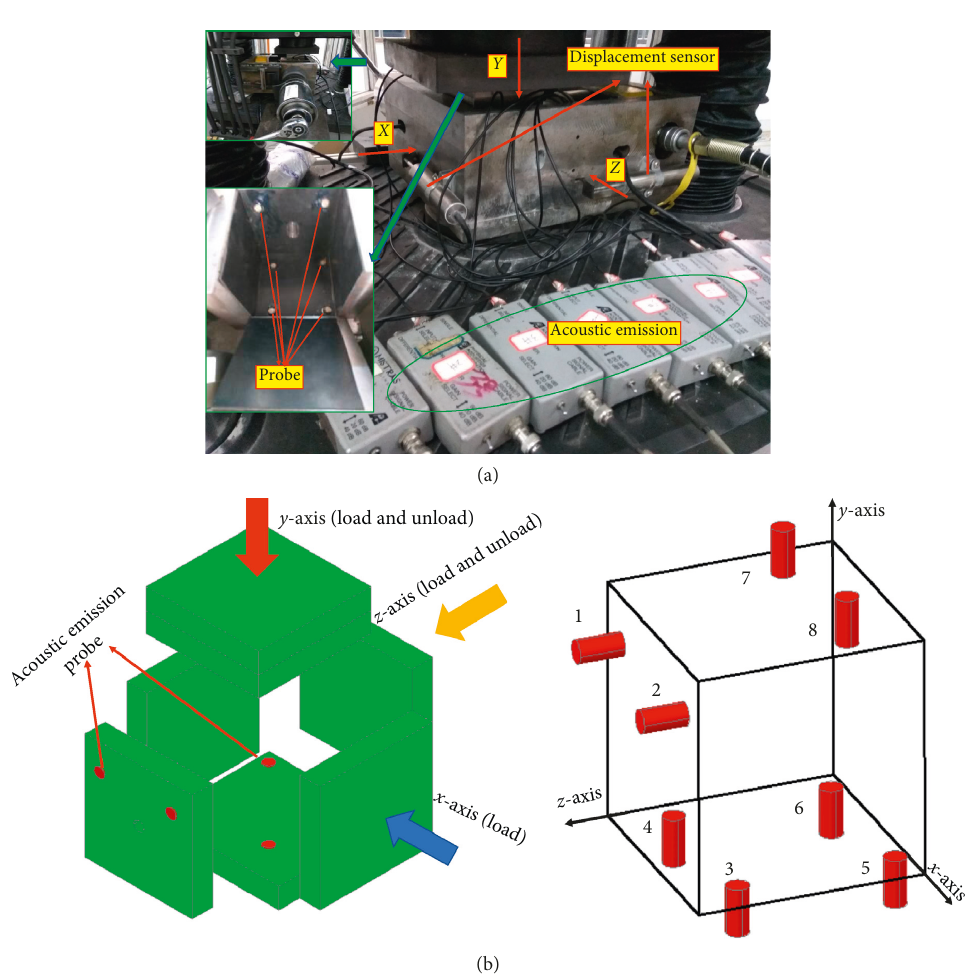
Figure 1: Experimental system. (a) Experimental apparatus. (b) Layout of the triaxial clamps and acoustic emission probes. Table 1: Basic properties of the tested material. Property Mean value Longitudinal wave velocity 1200m/s Density 1400kg/m 3 Compressive strength 8MPa Elastic modulus